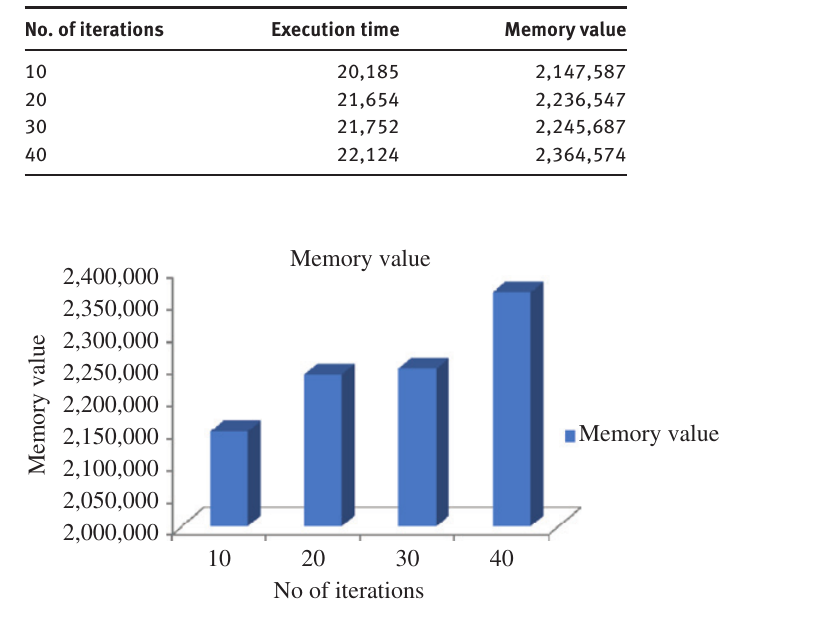
Figure 4: Memory Value for the Proposed Technique.